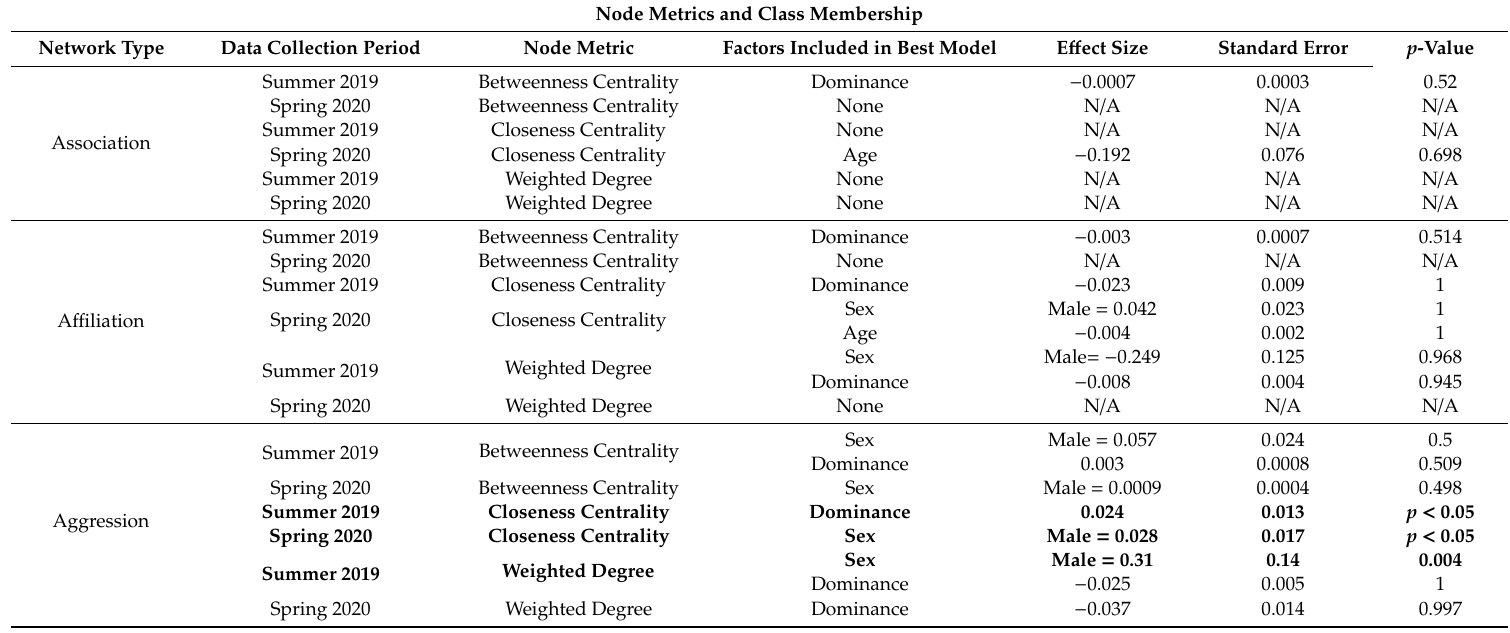
Table 3. This table shows the best models for predictor variables (age, sex, and dominance) on node metrics (betweenness centrality, closeness centrality, and weighted degree) for each network, as well as the e ff ect size estimate of each variable within that model, the standard error of those e ff ects, and the statistical significance after permutation testing. Statistically significant e ff ects are highlighted in bold. E ff ect sizes are given for males relative to females where sex was a factor in the best